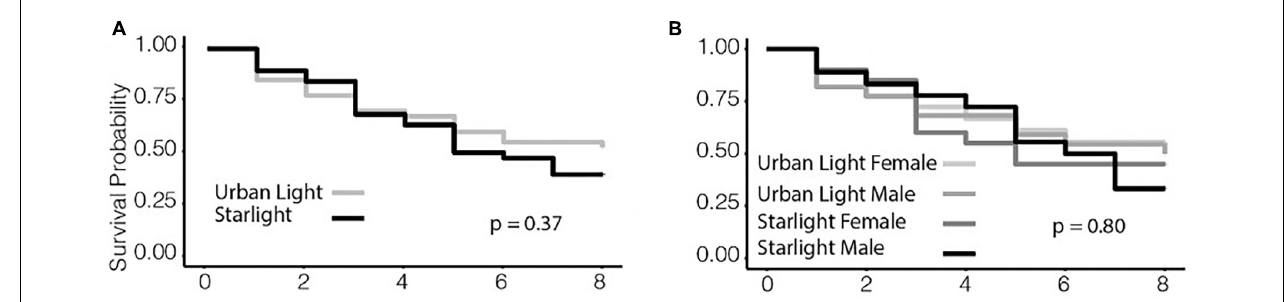
FIGURE 4 | Survival probability of crickets. (A) Survival probability of crickets under urban light and starlight treatments. (B) Survival probability of crickets under urban light and starlight treatments, split by sex in each treatment group. In both comparisons (A,B) , there were no differences in survival.